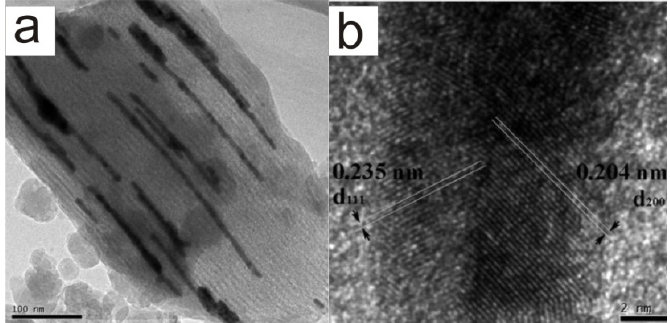
Figure 14. ( a ) Typical TEM image of Au/SBA-15 nanocomposite and ( b ) high-resolution TEM image of Au nanowire confined in SBA-15. Reproduced with permission from [47]. Copyright 2008 American Chemical Society.